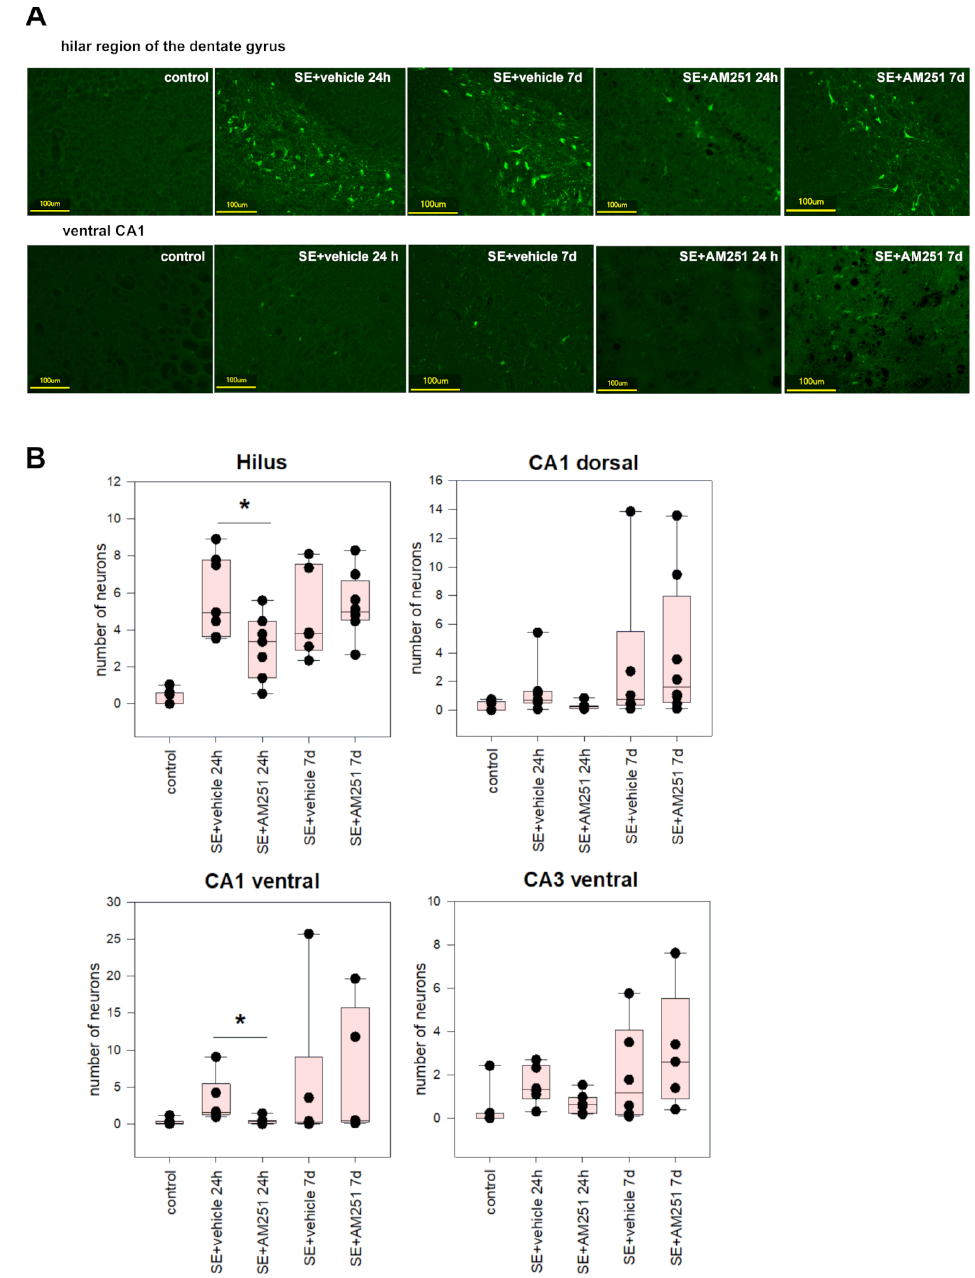
Figure 4. ( A ) Fluorojade C staining in the hilar region of the dentate gyrus (upper row) and CA1 of the ventral hippocampus (bottom row) in rats without SE (control), vehicle-treated treated rats (SE + vehicle), and AM251-treated rats (SE + AM251) 24 h and 7 days after SE; ( B ) the number of fluorescent neurons per field of view in rats with no SE (control), vehicle-treated treated rats (SE + vehicle), and AM251-treated rats (SE + AM251) 24 h and 7 days after SE. Data are presented as medians with interquartile ranges; dots represent individual values for each rat. *—significant differences at p < 0.05, Kruskal–Wallis test.